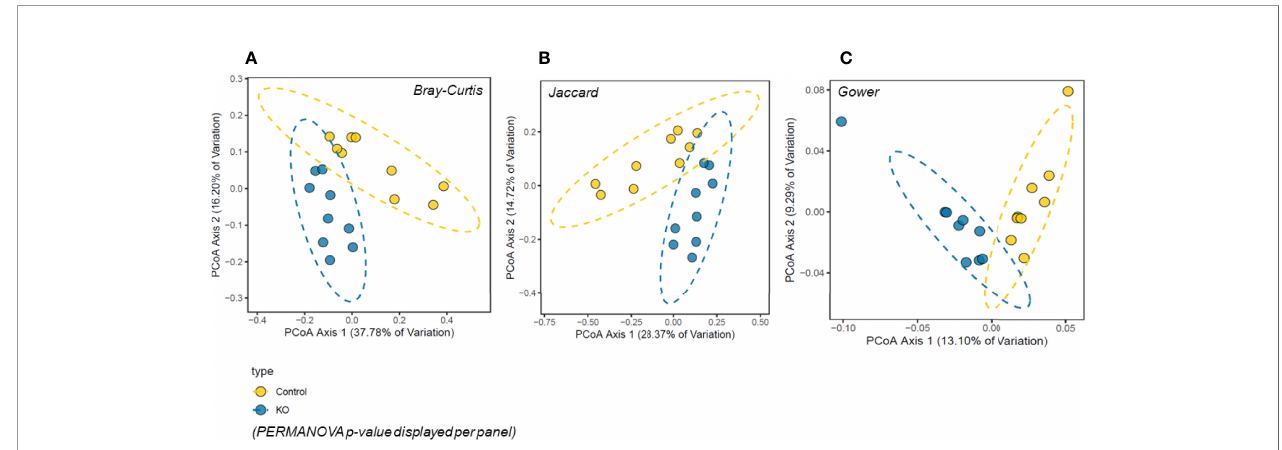
FIGURE 1 | b -diversity principal coordinates analysis (PCoA) in NHE3 IEC-KO and control mice. Microbiota composition was signi fi cantly different between the two genotypes ( n = 9/genotype) by three different measures of beta-diversity: (A) Bray-Curtis, (B) Jaccard, and (C) Gower distances (PERMANOVA p-value displayed per panel). Percentage of variation explained per PCoA axis is displayed with the axis